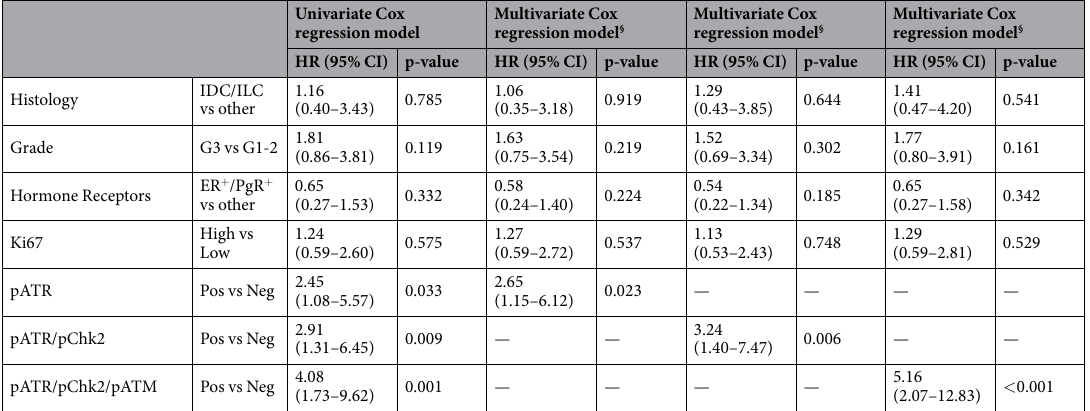
Table 4. Univariate and multivariate Cox regression models for 10-year survival in patients with available information on Ki-67 levels (N = 99). § Adjusted for : Histology, Grade, Hormone Receptor Status,